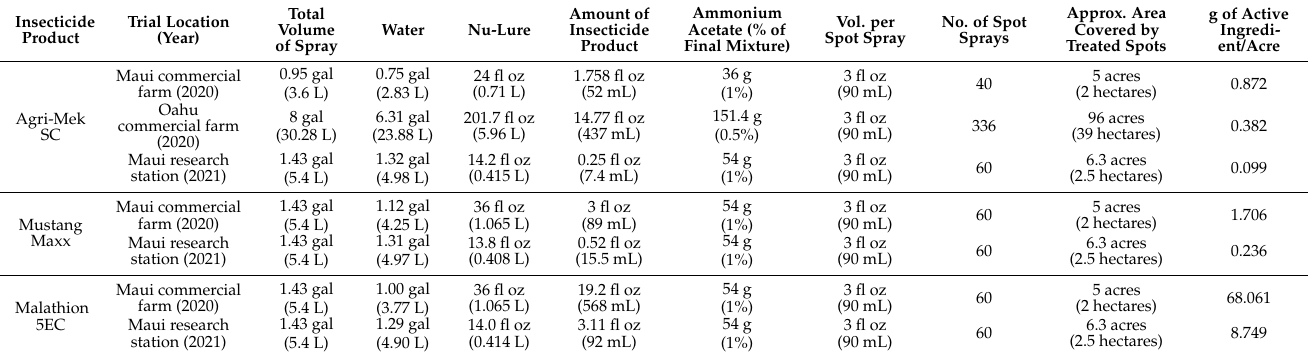
Table 3. The amount of each insecticide (mixed with Nu-Lure Insect Bait) applied to roosting plants of Zeugodacus cucurbitae in the perimeter of cucurbit crop fields per application during field trials that tested each insecticide separately. The approximate area covered by the treated spots is the area of cucurbit crops inside the surrounding treated roosting plants.